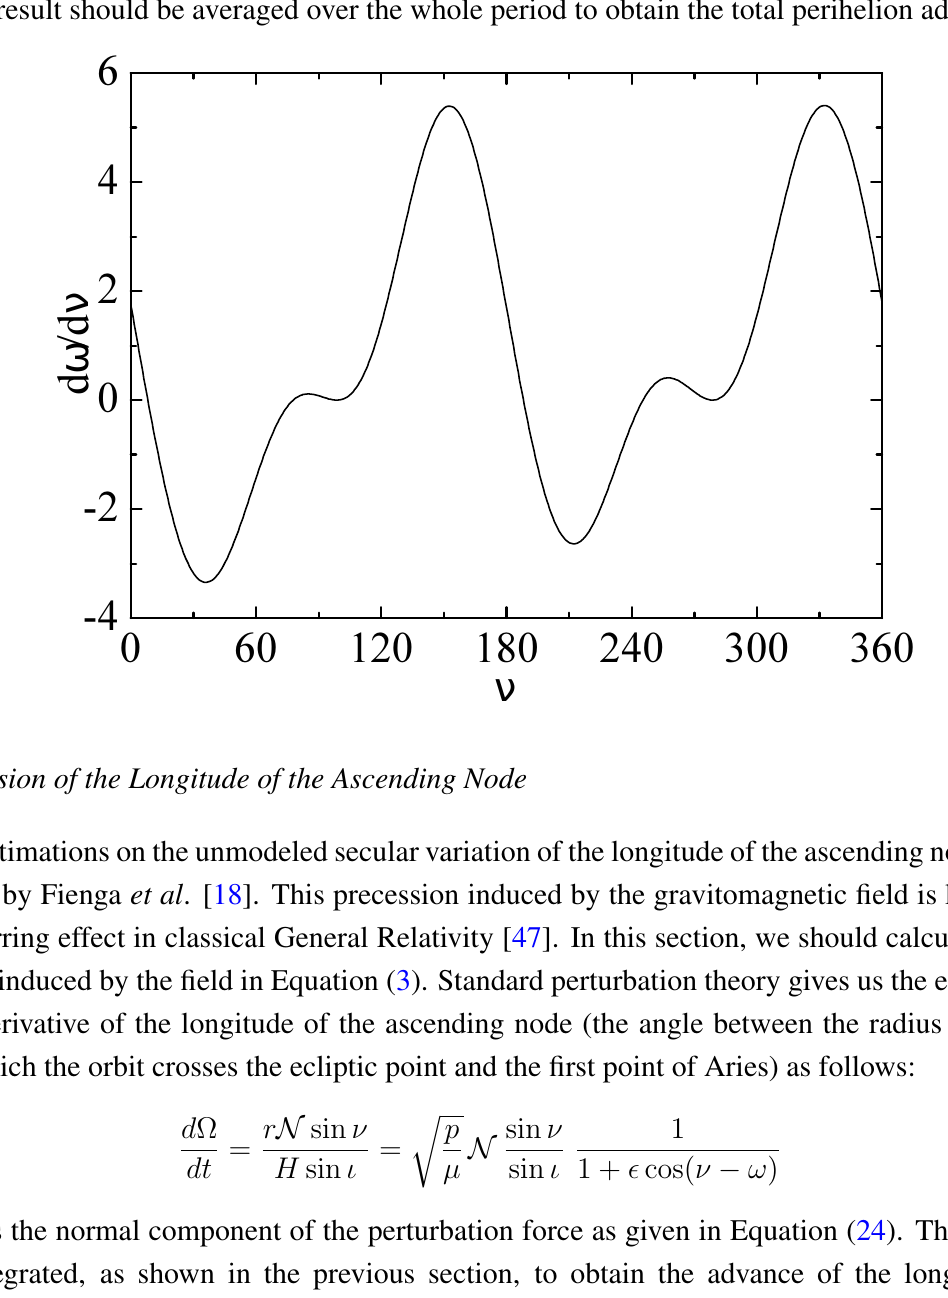
Figure 2. The instantaneous derivative of the argument of the perihelion (arcseconds per century) in terms of the true anomaly (in sexagesimal degrees) for the anomalous gravitomagnetic law in Equations (3) and (16) with the parameters n = m = 2 and β = 1 . This result should be averaged over the whole period to obtain the total perihelion